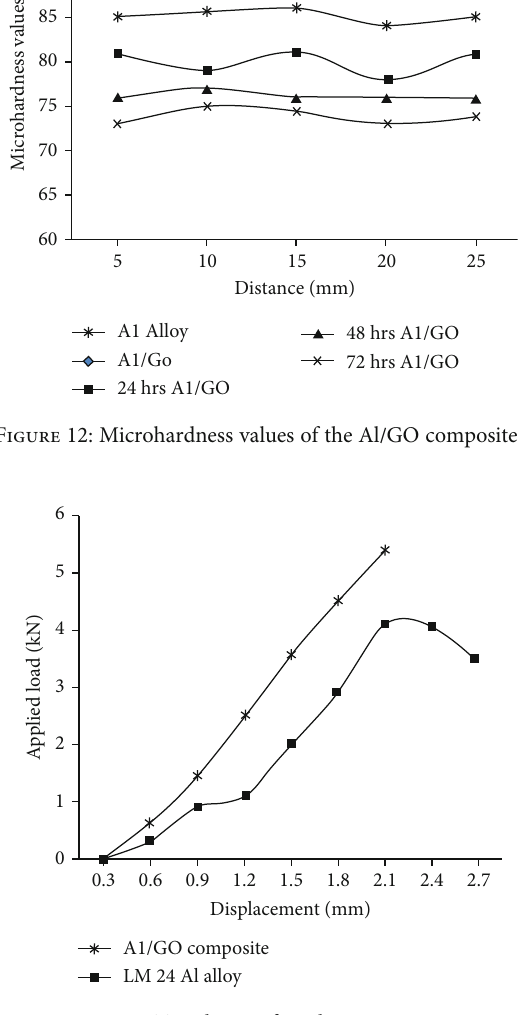
Figure 13: Tensile cure for Al/GO